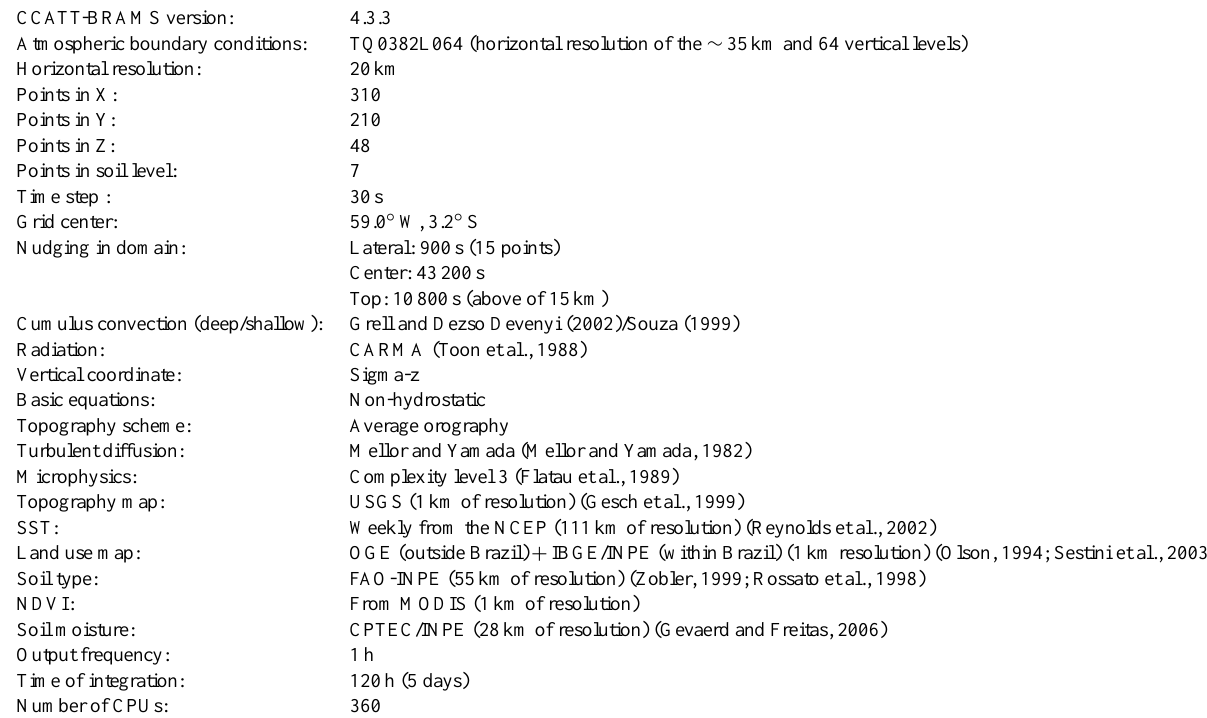
Table 1. Main parameters and parameterizations used in the CCATT-BRAMS model. 4.3.3